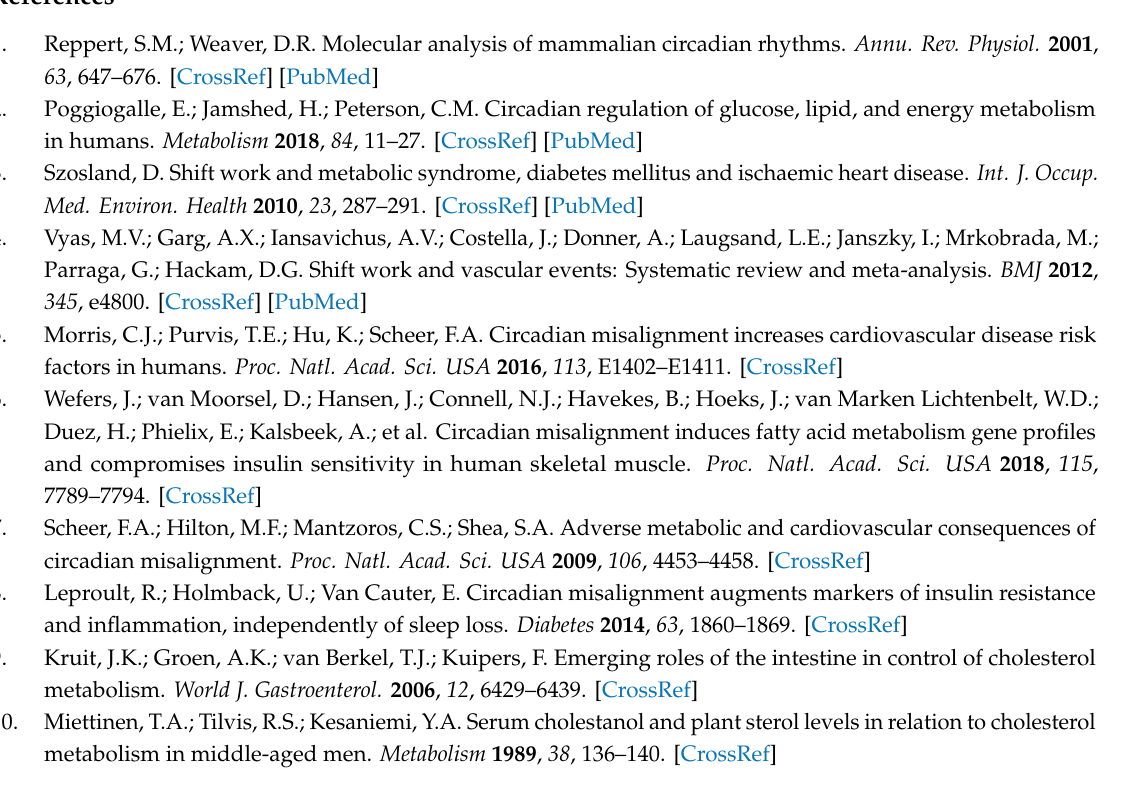
Table S1: Lathosterol levels ( µ mol / mmol cholesterol) of the included studies; Table S2: Mevalonate concentrations (pmol / mL) of the included studies; Table S3: VLDL-squalene levels ( µ mol / mmol free cholesterol) of the included studies; Table S4: LDL + HDL-squalene levels ( µ mol / mmol free cholesterol) of the included studies; Table S5: C4 levels (nmol / mmol cholesterol) of the included